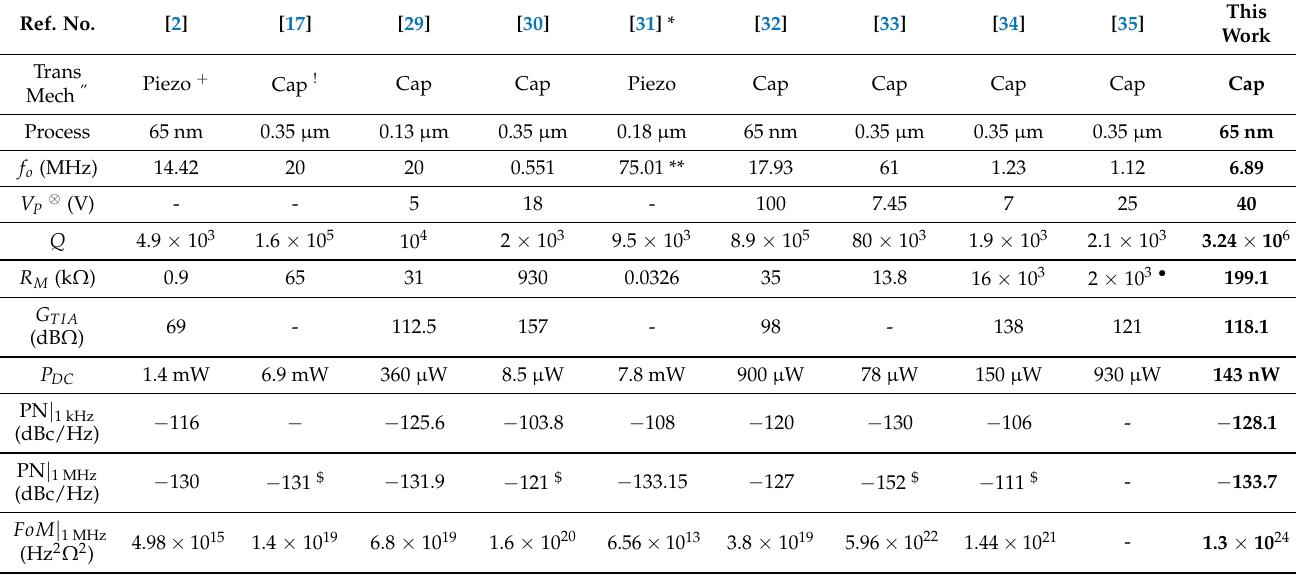
Table 2. Oscillator Performance Summary and Comparison to the State-of-the-Art. Ref.